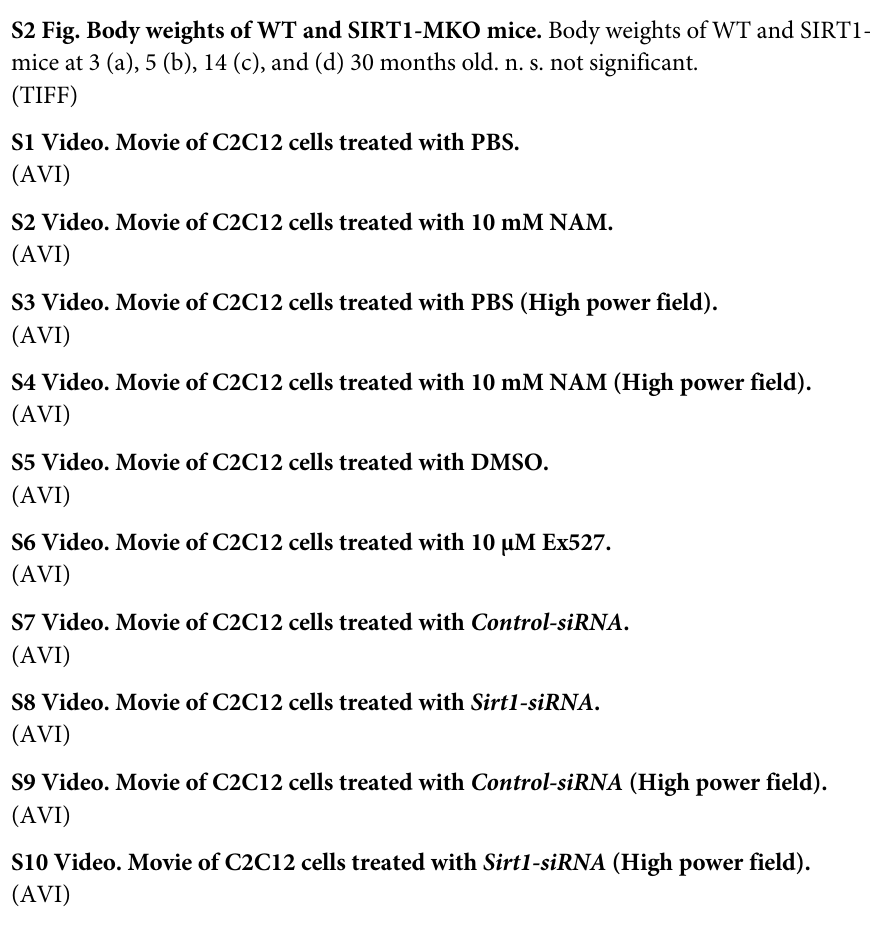
S2 Fig. Body weights of WT and SIRT1-MKO mice. Body weights of WT and